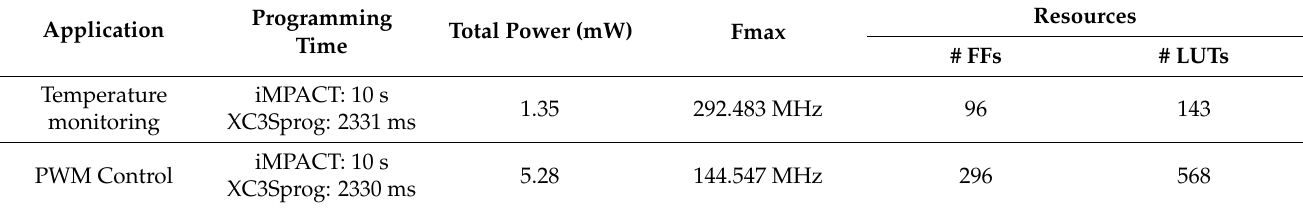
Table 5. Power consumption and logic resources for PWM fan control vs. temperature sensing.